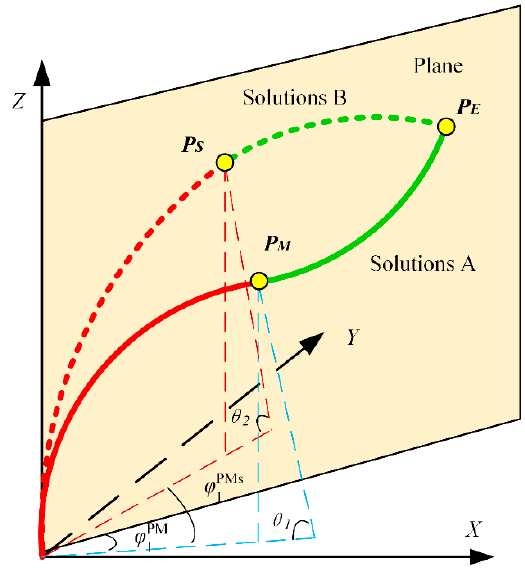
Figure 7. Two symmetric solutions at P E OZ .